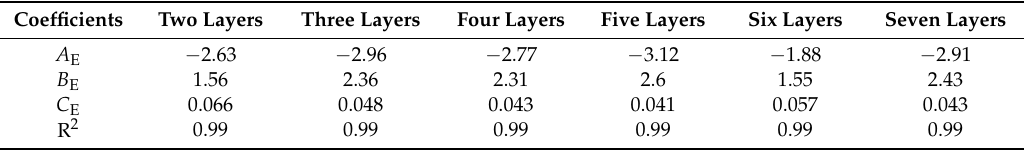
Table 2. Fitting coefficients for interface charge density absolute value at steady state (1800 s) under different electrical field strengths for multi-layer oil-paper